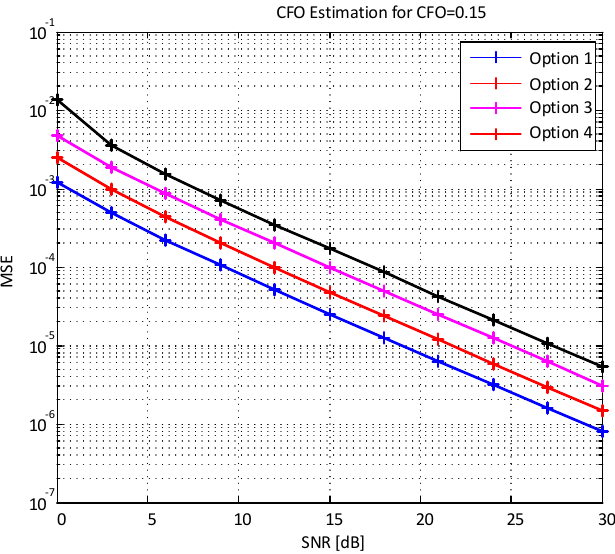
Figure 5. MSE of the cyclic prefix technique with four options .